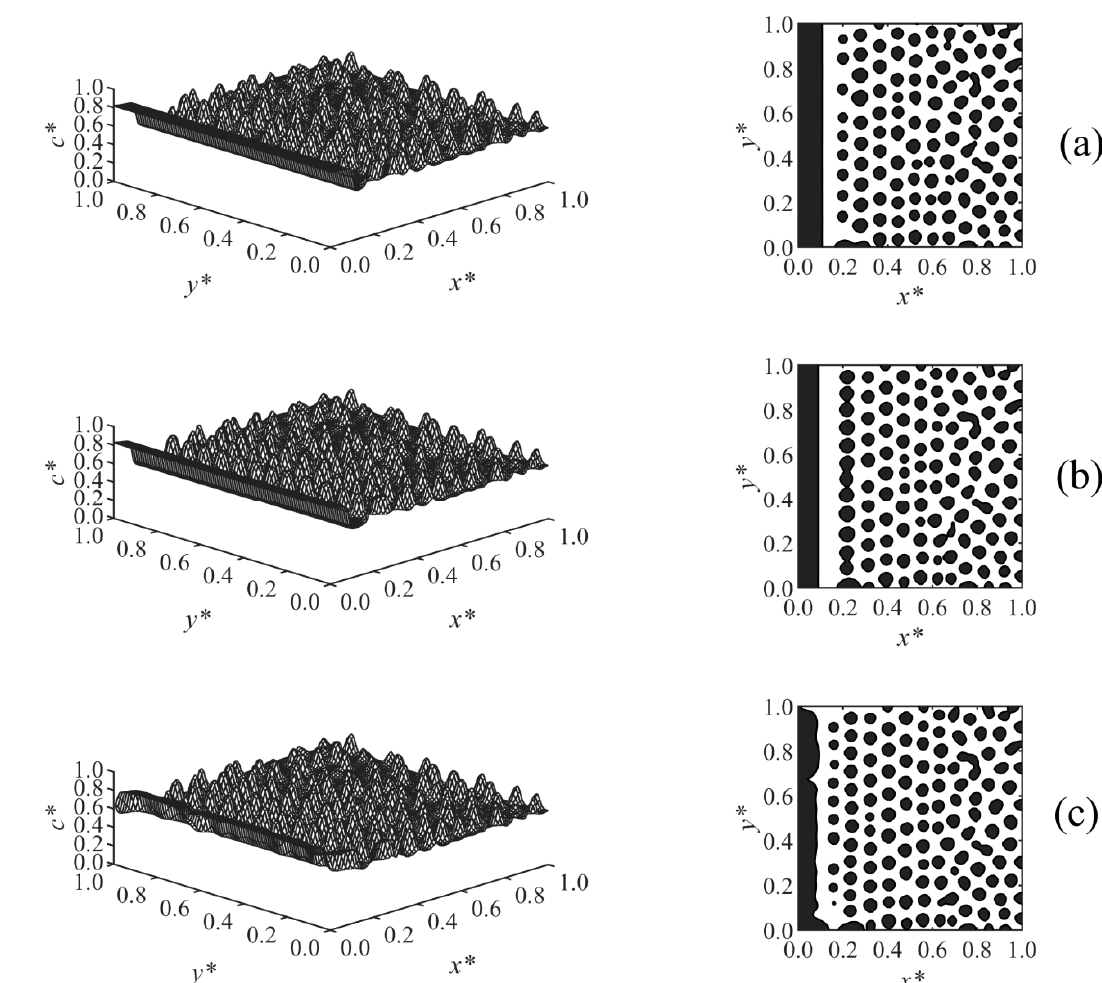
Figure 5. Spatial concentration distributions (first column) and phase-separated morphologies (second column) for Case 3 at t * = 9.8425 × 10 − 5 , at the following exponents of surface potential: ( a ) n = 2, ( b ) n = 3, and ( c ) n = 4.